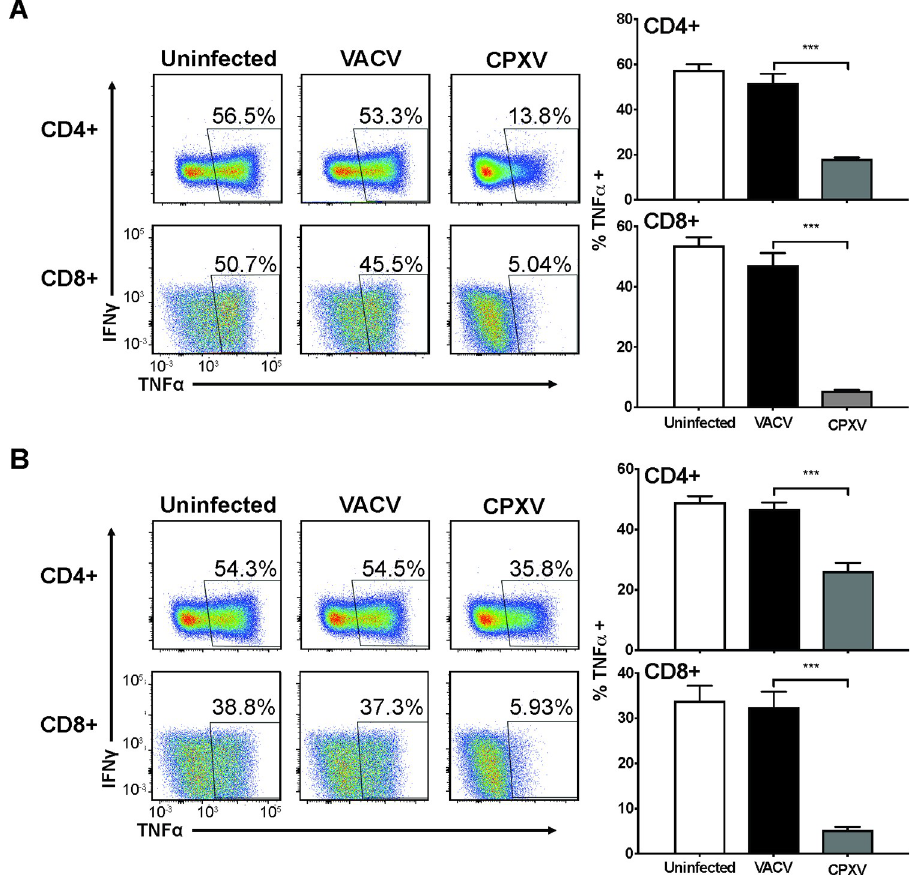
Fig 1. A secreted factor of CPXV prevents the activation of na ï ve T cells by anti-CD3 and anti-CD28. A) Reduced activation of na ï ve murine T cells by anti-CD3 and anti-CD28 in the presence of CPXV-infected cells. Murine A20 B cell lymphoma cells were infected at a multiplicity of infection (MOI) of 5 for 16h with CPXV or VACV, or uninfected prior to co-incubation with splenocytes from BALB/cByJ mice for 4h and transfer to plate-bound α -CD3 ε and α - CD28 antibodies followed by ICS for IFN γ and TNF α (S1 Fig). B) CPXV-infected cells secrete a factor that prevents T cell activation. Murine MC57 fibrosarcoma cells were infected with CPXV, VACV (MOI = 5) or uninfected for 16h. Supernatants were harvested and incubated for 4h with splenocytes from BALB/cByJ mice followed by transfer to plate-bound α -CD3 and α -CD28 antibodies and ICS as in (A). Left: representative dot plots. Values represent the percentage of TNF α + cells gated on live CD3+ CD4+ or CD8+ lymphocyte single cells. Right: Average frequencies of TNF α + CD4+ or CD8+ T cells (+SEM) of 3 individual experiments each with 5 mice. Error bars indicate the Standard Error of Mean (SEM), p-values were calculated using unpaired two-tailed Student’s T test ( ��� p � 0.001). to the five ORFs CPXV11 to CPXV15. Only two of these five ORFs encoded proteins predicted to be secreted: CPXV15 and CPXV14. CPXV15 was a possible candidate for the T cell inhibi- tory factor since this ORF encodes a soluble TNF receptor (TNFR) family protein with homol- ogy to CD30 [24]. Moreover, the ectromelia virus (ECTV) homolog of CPXV15 was previously shown to block IFN γ production by T cells [25]. Using the previously generated ORF15-deletion mutant A624 [24] we examined the ability of CPXV15 to prevent Ab-medi- ated T cell activation. However, when co-incubated with α -CD3 and α -CD28 activated spleno- cytes, A624 still inhibited CD4+ and CD8+ T cell activation thus ruling out ORF15 as the responsible ORF ( Fig 2C ). The remaining candidate, CPXV14, belongs to a superfamily of proteins that share sequence and structural features termed the poxvirus immune evasion (PIE) domain [21].